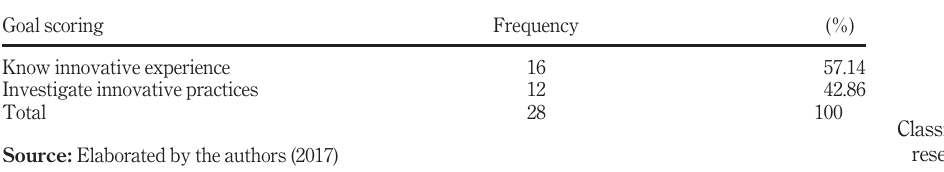
Table II. Classi fi cation of